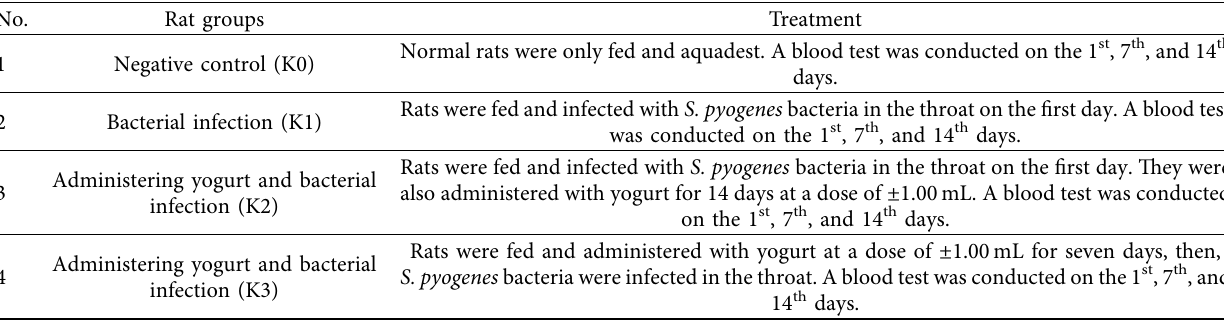
Table 1: Treatment group on experimental rats [11].